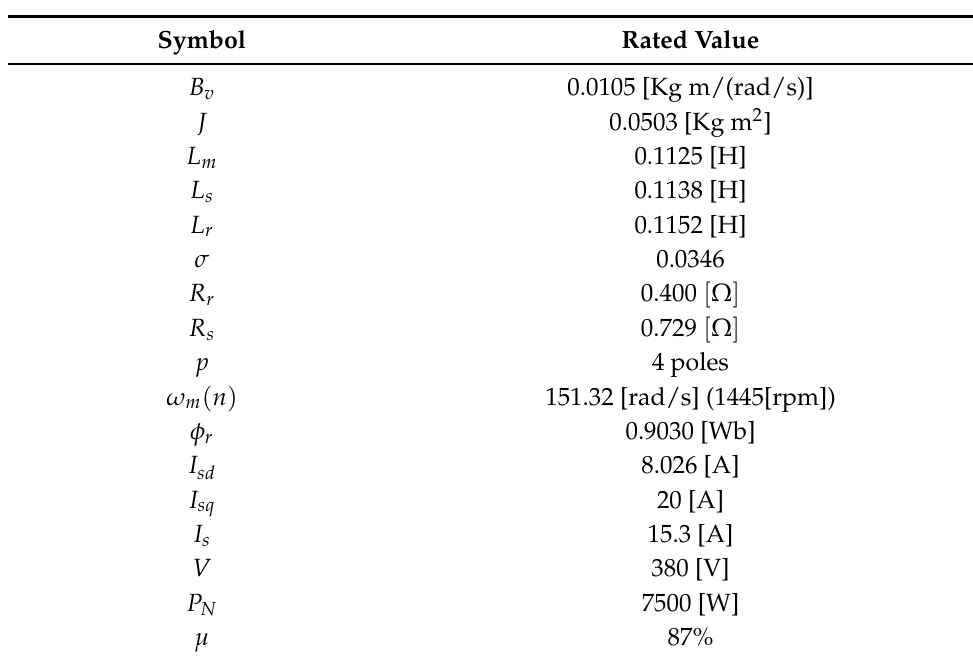
Figure 2. Experiment platform for IM with load torque. Table 1. Parameters of the M2AA 132M4 ABB Induction Motor 7.5 (rpm) and 1445